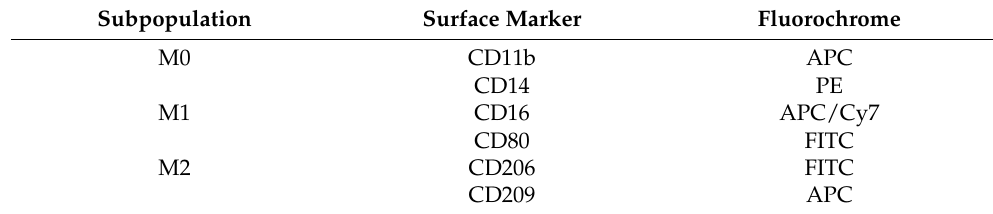
Table 6. Surface markers of each subpopulation of THP-1-derived macrophages. Subpopulation Surface